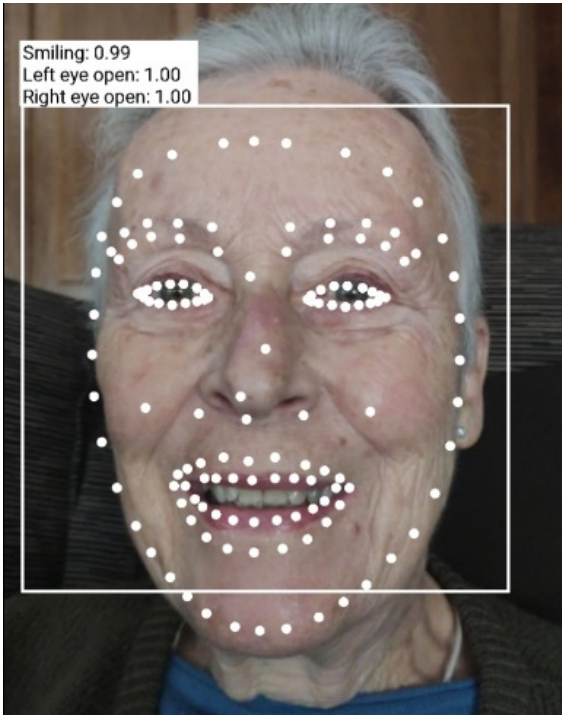
Figure 1. Example of identification of a face with the corresponding smile index. The smile index in this case is of 0.99, meaning that the person is clearly